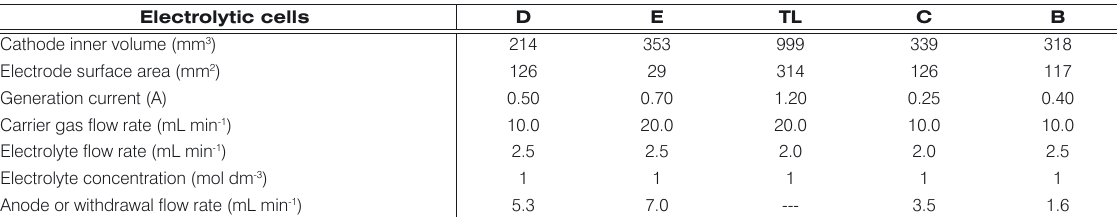
Table 1. Cathode inner volumes and optimal working parameters of used cells. Electrolytic